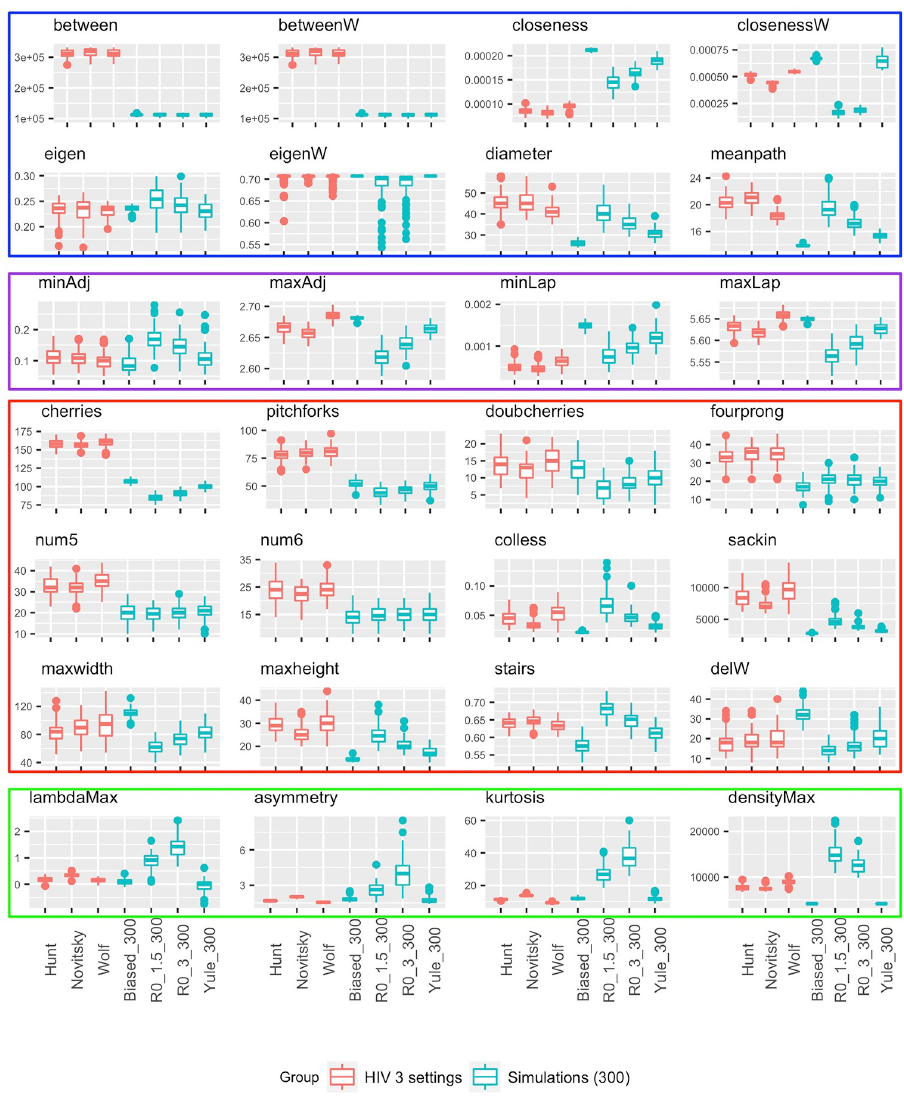
Fig 3. Tree summaries for HIV in three settings and simulations of size